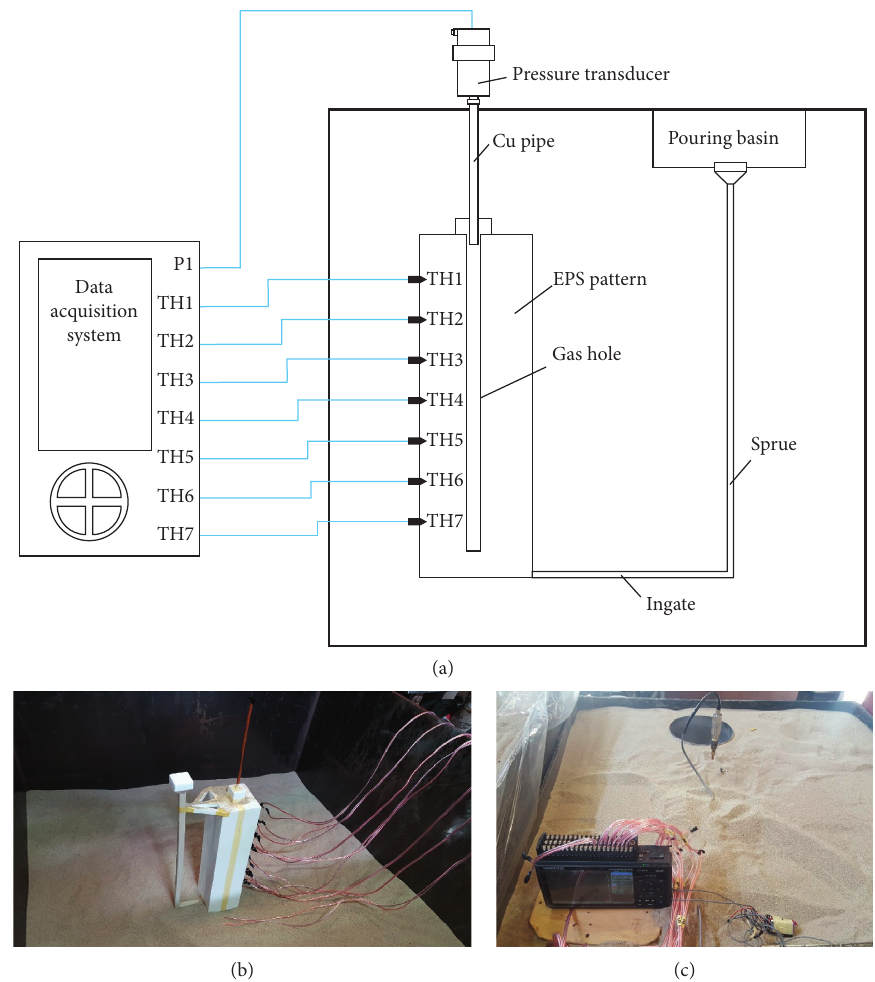
Figure 2: Schematic and photographs of the setup for measuring the kinetic zone pressure. (a) Schematic illustration of the actual casting experiment, (b) photograph showing before sand compaction, and (c) photograph showing the state before the pouring. Table 1: Grain distribution of dry sand used as molding sand in this study. Mesh no. 30 40 50 70 100 140 200 270 Pan Wt.%